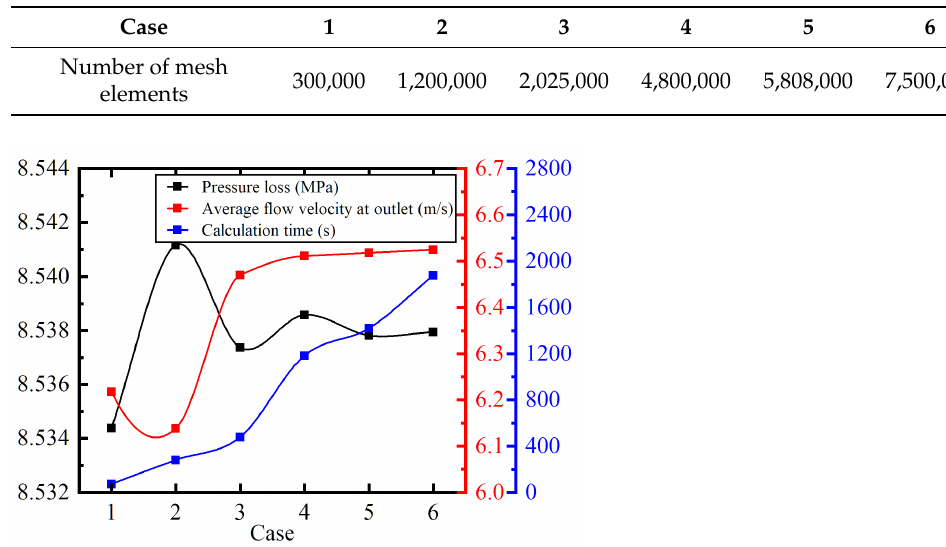
Table 1. Sets of mesh elements.